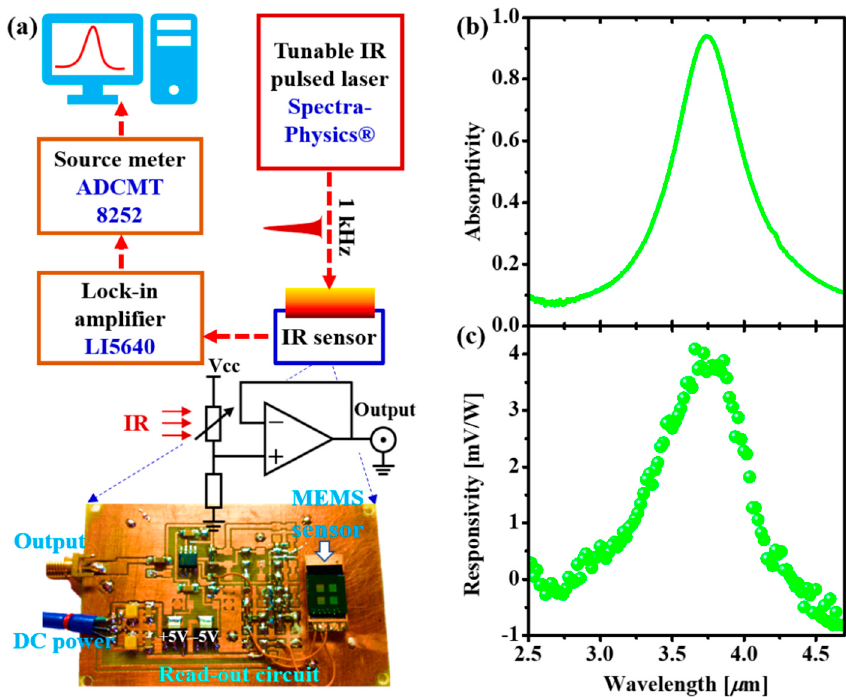
Figure 5. ( a ) Measurement setup of the spectral response of the fabricated bolometers. ( b ) Measured absorptivity and ( c ) Measured responsivity curves of a 3.73 µm resonant bolometer.